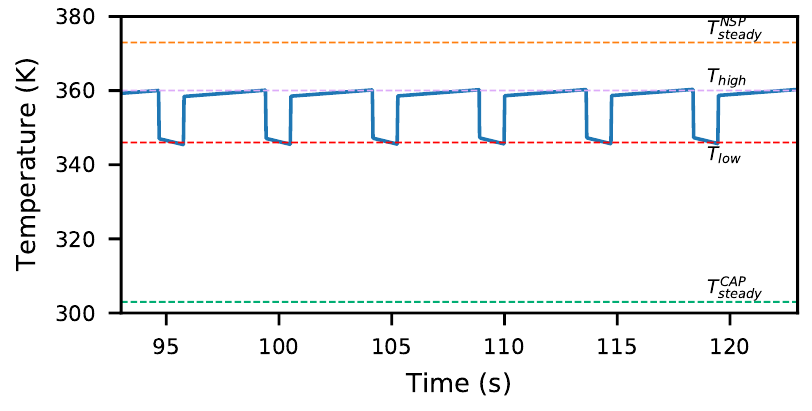
Figure 6. Transient response of seasonal migration mechanism with 77% duty cycle to confine sensor temperature within thermal boundaries ( T high and T low